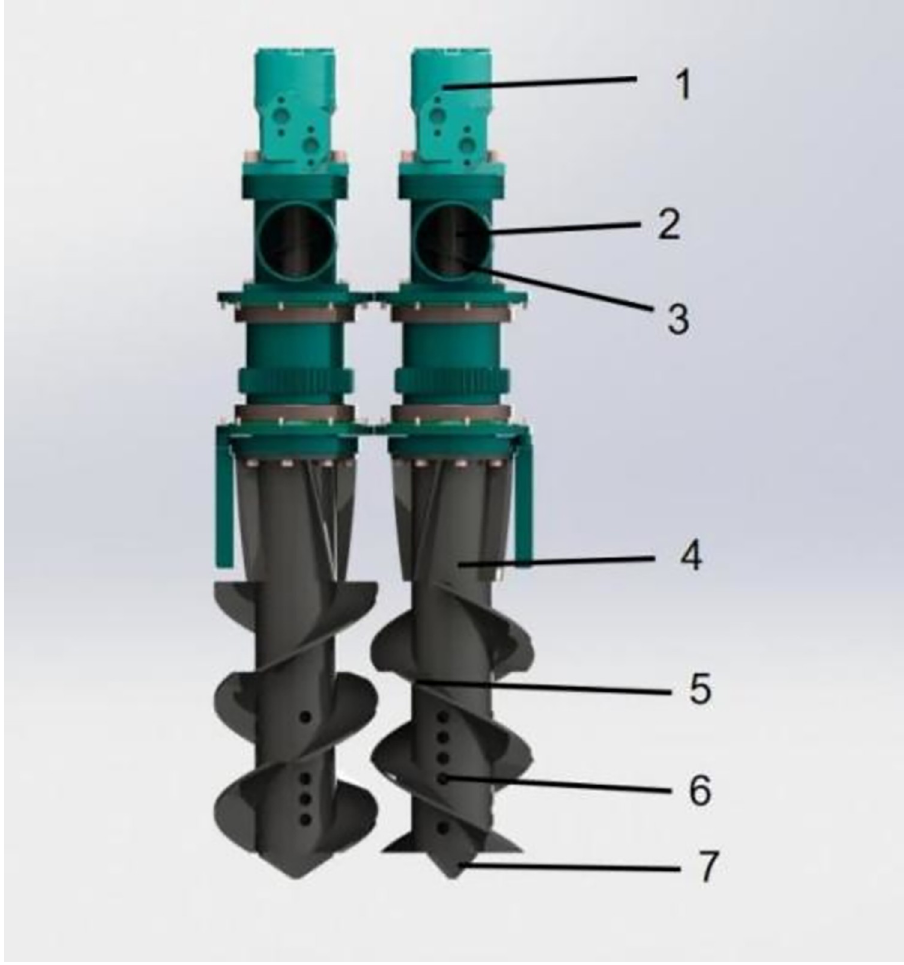
Fig 3. Structure of the trenching and fertilizing mechanism. 1. hydraulic motor 2. fertilizer discharge screw conveyor 3. fertilizer inlet hole 4. shaft cover 5. auger blade 6. fertilizer discharge hole 7. auger